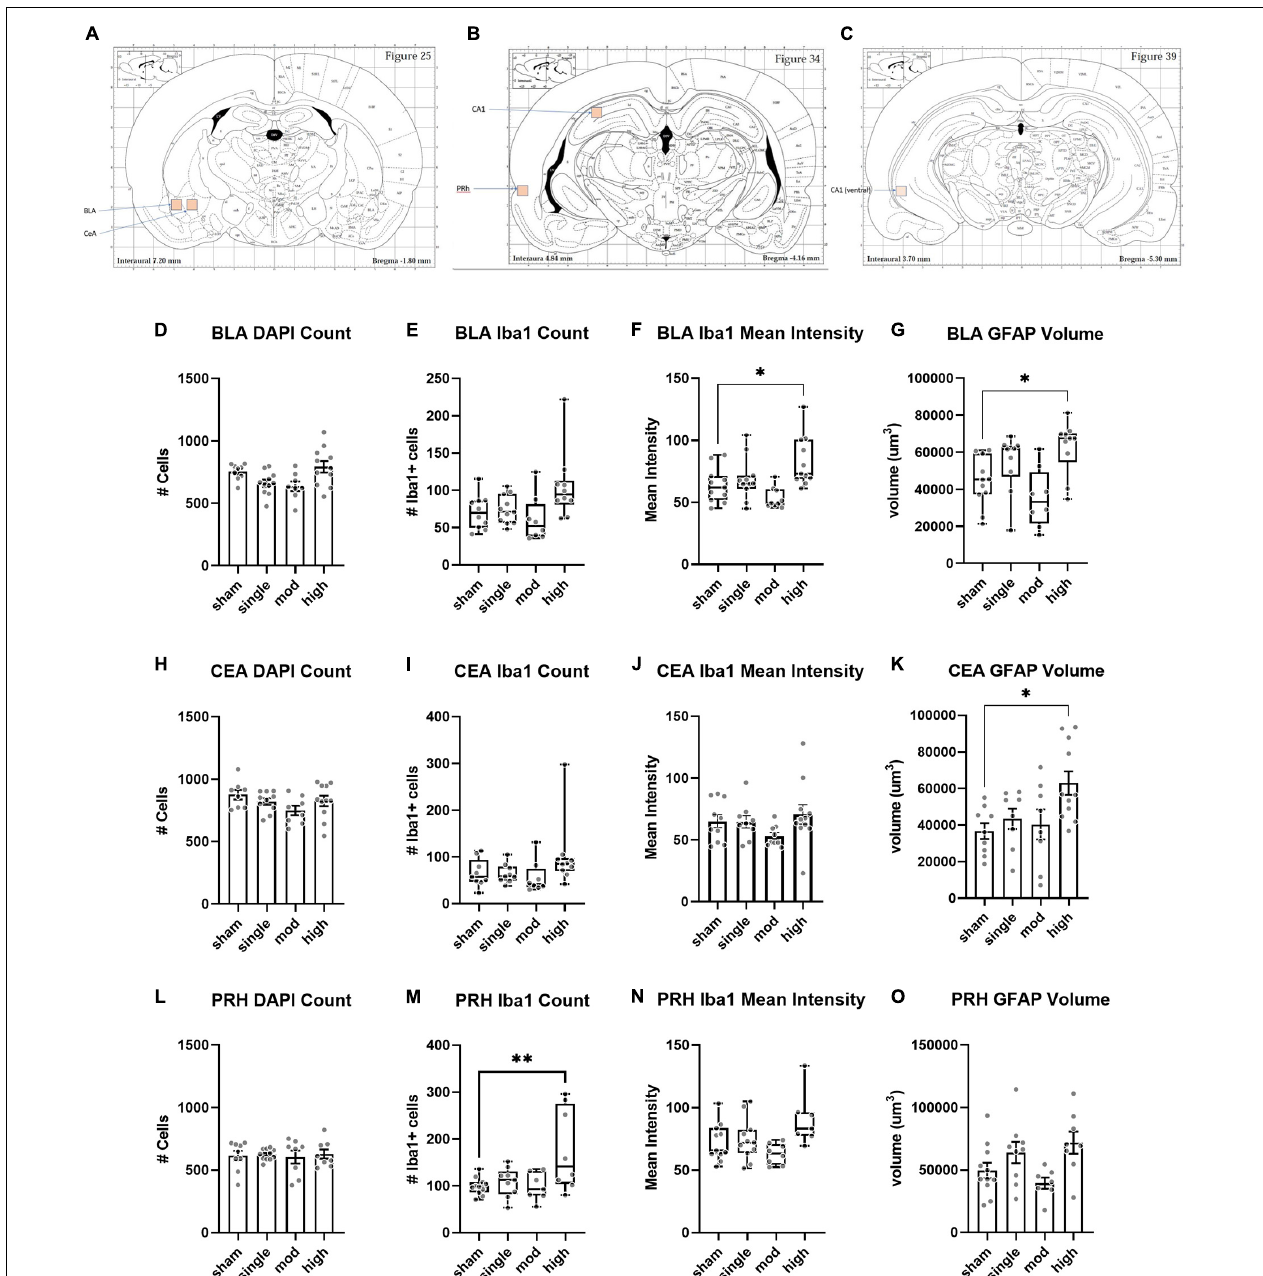
FIGURE 5 | Histopathology analysis of amygdala and perirhinal cortex. (A–C) Regions of interests (ROIs) used for analyses. (D–G) Basolateral amygdala (BLA), (H–K) Central amygdala (CEA), (L–O) Perirhinal cortex (PRH). Bars represent mean ± SEM. Boxes/whiskers represent median, quartile, and range in non-normal datasets. Normally distributed data were analyzed by one-way ANOVA followed by Dunnett’s post hoc tests. Non-normal data were analyzed by Kruskal–Wallis tests followed by Dunn’s post hoc tests. ∗ p ≤ 0.05, ∗∗ p ≤